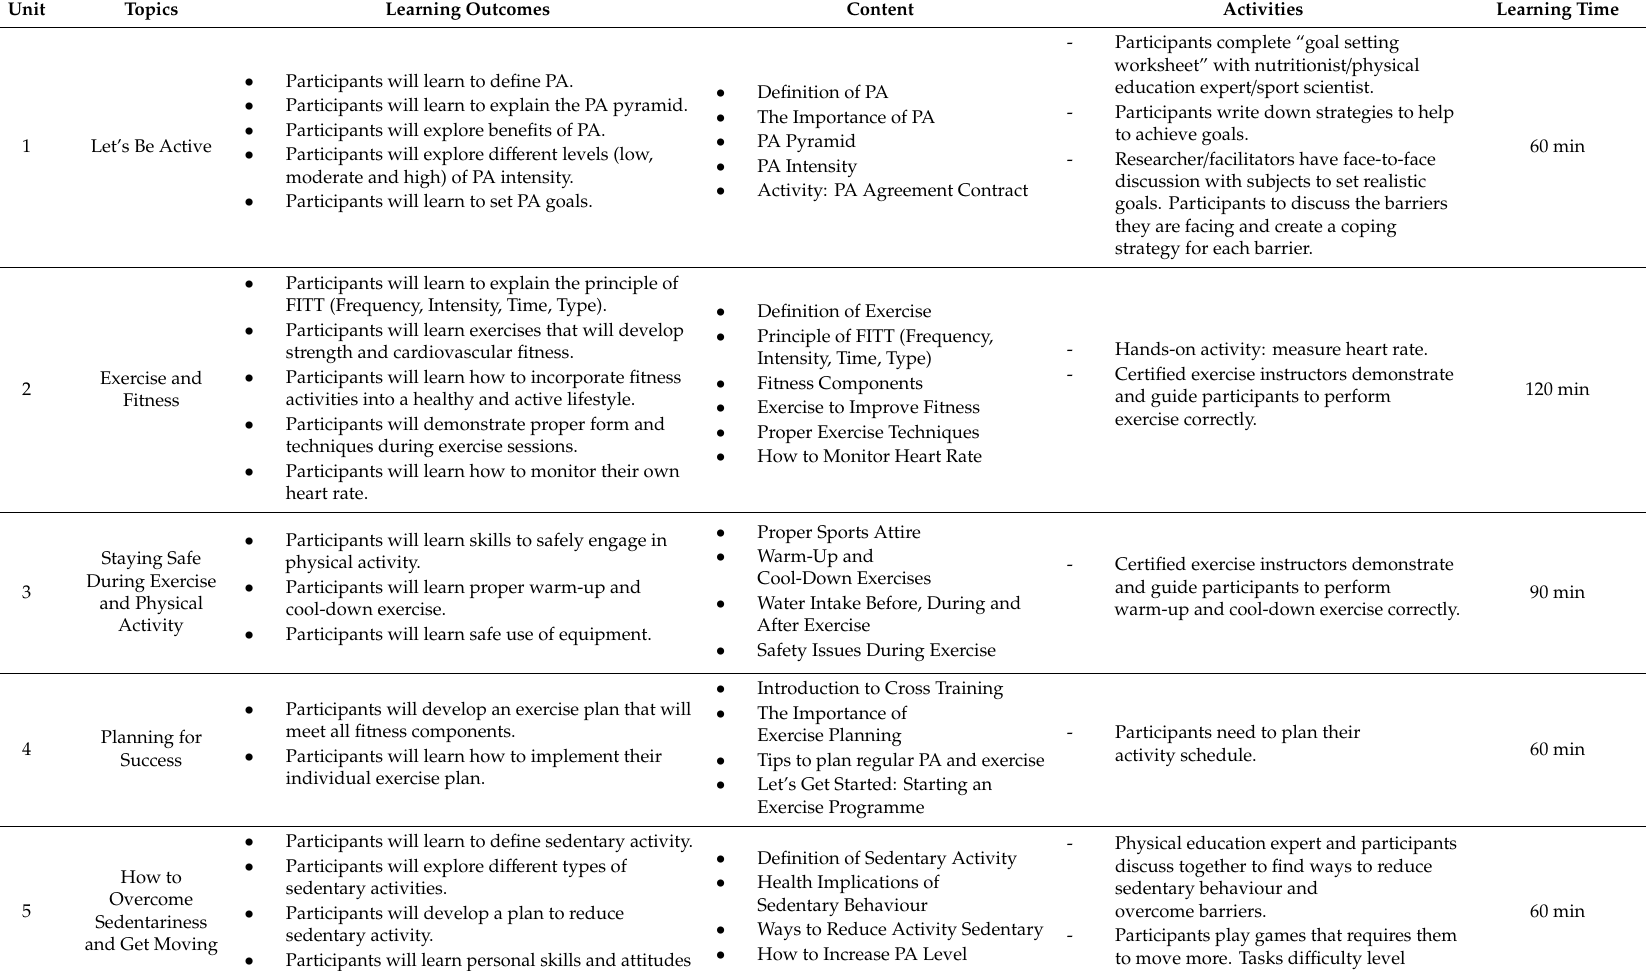
Table 3. Topics, learning outcomes, content and activities of the Physical Activity (PA)